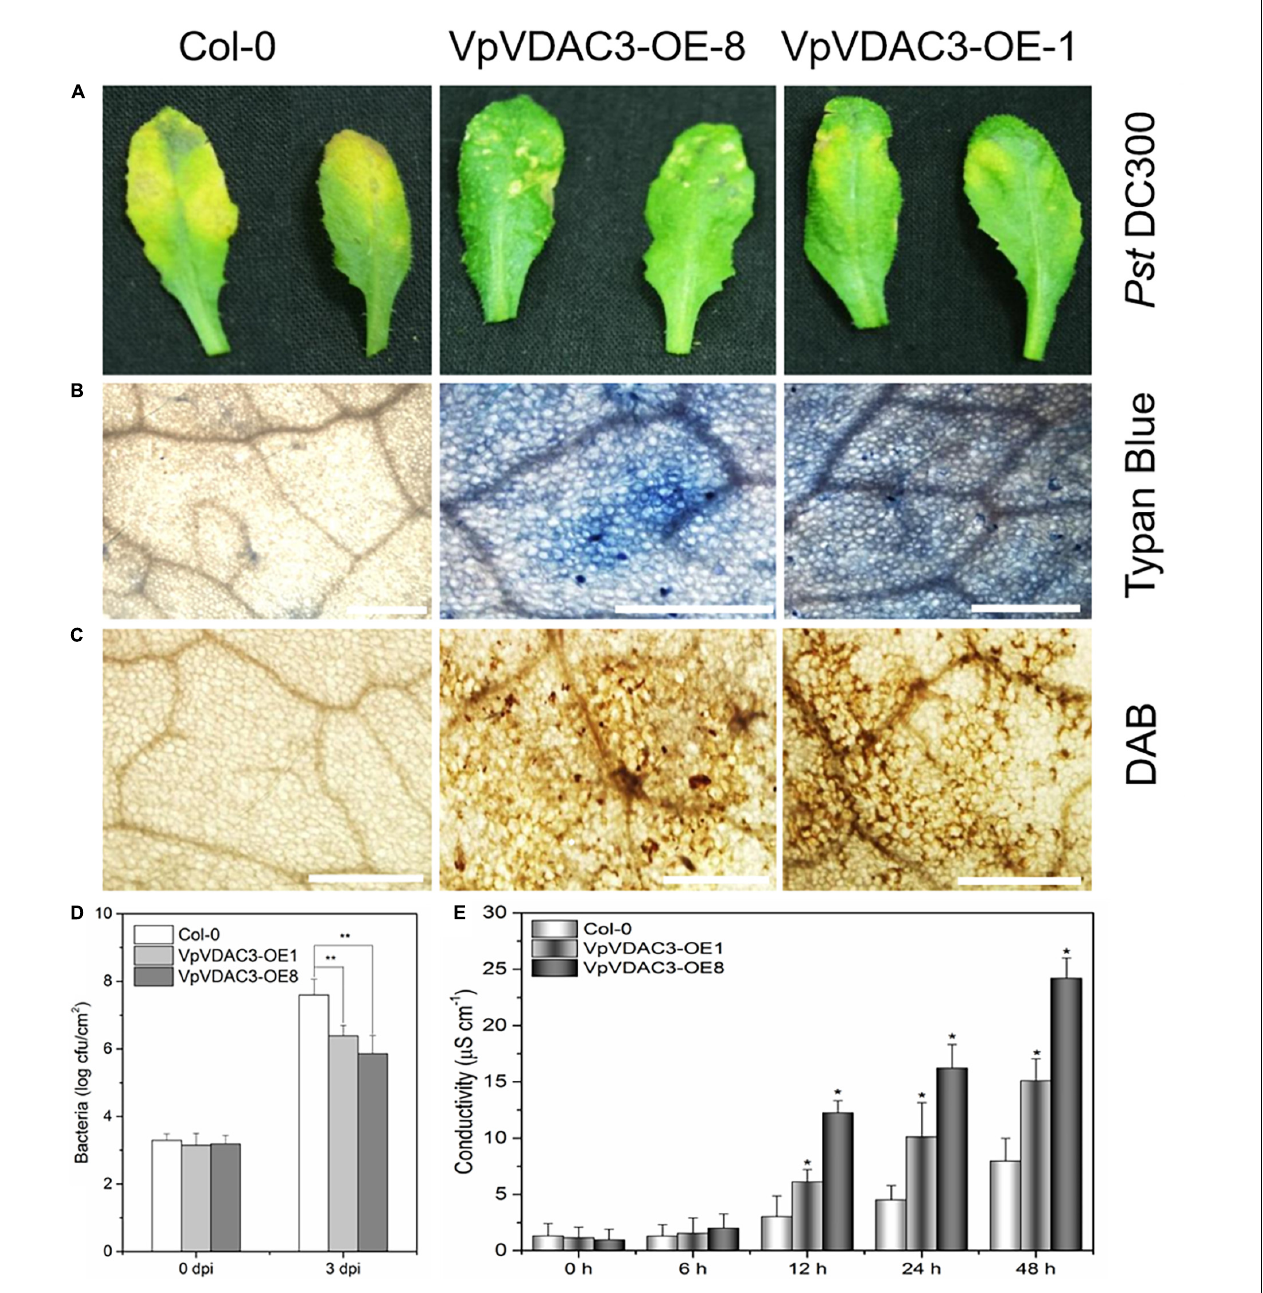
FIGURE 8 | Enhanced Pst DC3000 resistance in VpVDAC3 -OE transgenic Arabidopsis . (A) Disease symptoms on leaves 72 h after inoculation. (B) Micrographs of leaves stained with trypan blue 24 h after infiltration. (C) Micrographs of leaves stained with DAB 24 h after inoculation. (D) Bacterial growth in leaves inoculated with Pst DC3000, Bacterial populations were quantified at 0, and 2 dpi. Vertical bars indicate the standard errors for three independent experiments. (E) Ion leakage from leaf tissues inoculated with Pst DC3000. Error bars are the SD of three replications results. Error bars indicate the SE ( n = 3) from three independent biological replicates. An asterisk (*) indicates significant differences compared to the Col-0 line as determined by t -tests (* P < 0.05, ** P < 0.01) based on three independent replication